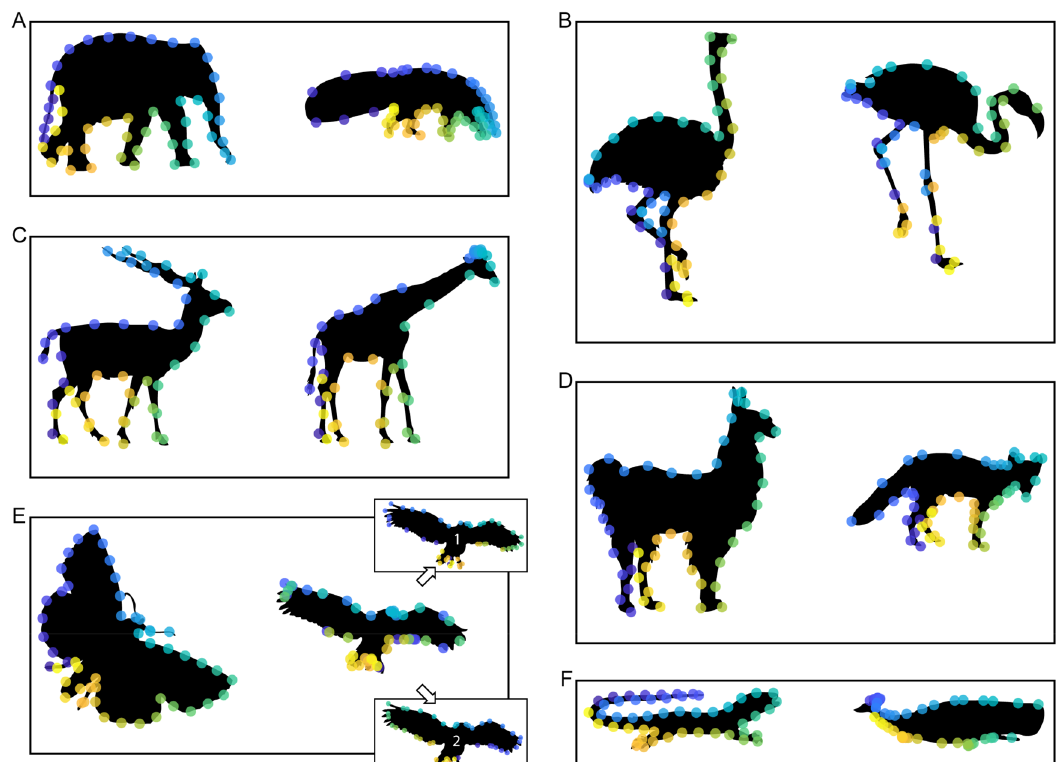
Figure 4. Overview of results of Experiment 1. On each base shape (left, e.g., elephant), we plot the 50 equidistant probe points. On each test shape (right, e.g., anteater), we plot the corresponding participant responses for each of the points. Participant responses are summarized by determining the median position along the length of the contour. ( A – D ) For most pairs and probe points, the order of points on the test shapes is the same as that on the base shape even though probe points were queried one at a time. ( E ) For the Butterfly– Owl pair, we also show results separately for participants arranging their responses in the same (inset 1) or reversed order (inset 2) as the probe points. Data are available at https ://doi.org/10.5281/zenod o.43042